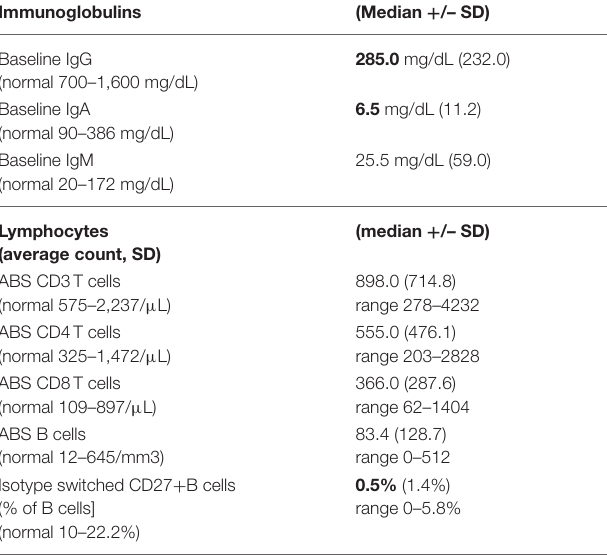
TABLE 2 | Immunologic laboratory data of CVID patients with ILD. Immunoglobulins